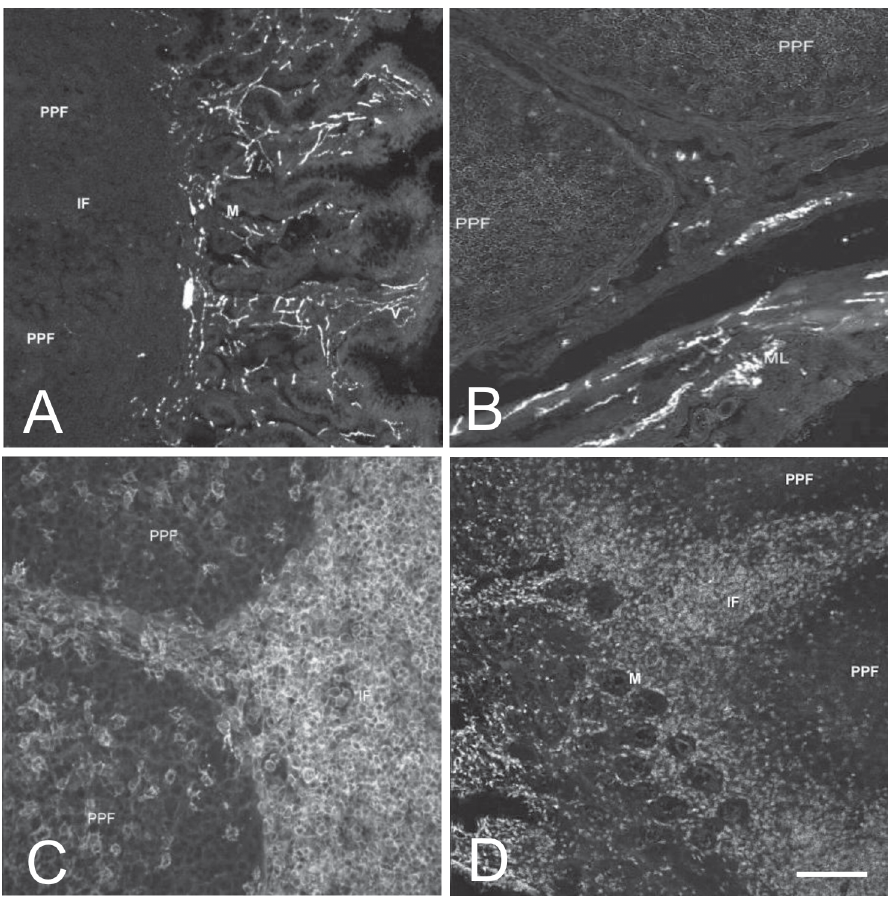
Fig 1. A–Gal-positive nerve fibers in the mucosal membrane of the ileum of 4 weeks-old animals. B–VIP-positive nerve fibers in the muscular membrane of the ileum of 4 weeks-old animals. C–CD2+ lymphocytes in the mucosal membrane of the ileum of 4 weeks-old animals. D–CD8+ lymphocytes in the mucosal membrane of the ileum of 4 weeks-old animals. Abbreviations: PFF–Peyer’s patch follicle, IF–interfollicular region, M–mucosa, ML–muscular layer. Bar: Fig A, D– 100 μ m, B– 50 μ m, C– 25 μ m.